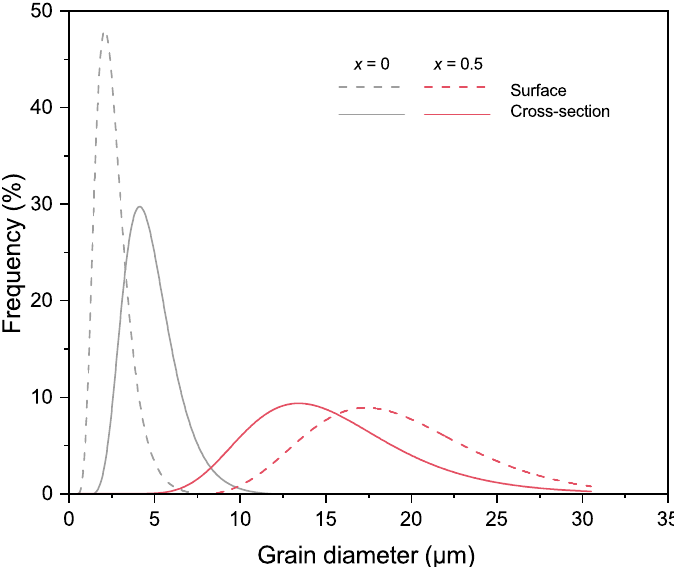
Figure A4. Grain size distribution of Pr 1– x Sr x (Cr,Mn,Fe,Co,Ni)O 3– δ membranes ( x = 0,0.5) fitted with a log-normal density function. The dashed lines show the distribution of grains from the membrane surface, whereas the solid lines demonstrate the distribution of grains from the membrane cross-section. The grain diameter d is calculated according to d = area of grains. In each case, 100 grains were evaluated.